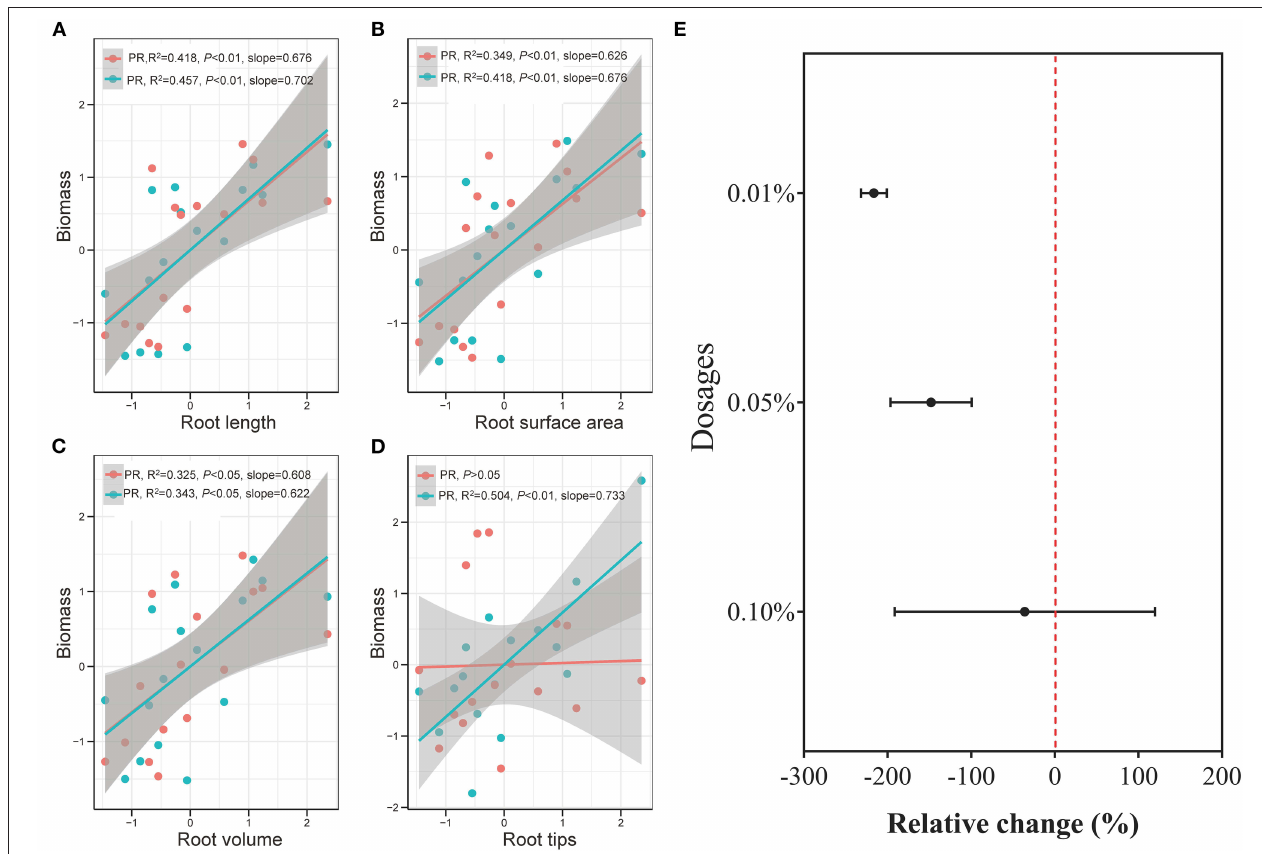
FIGURE 7 | Correlation between rice biomass and rice root length ( A , n = 16), surface area ( B , n = 16), volume ( C , n = 16), and tips ( D , n = 16), and between BCE dosages and rice growth traits ( E , n = 42) in Experiment 2a. Data were normalized by the Z-score scaling method (detailed in the Supplementary Material ) and the shaded bands with gray color show 95% pointwise confidence intervals. PR stands for primary roots, and SR stands for secondary